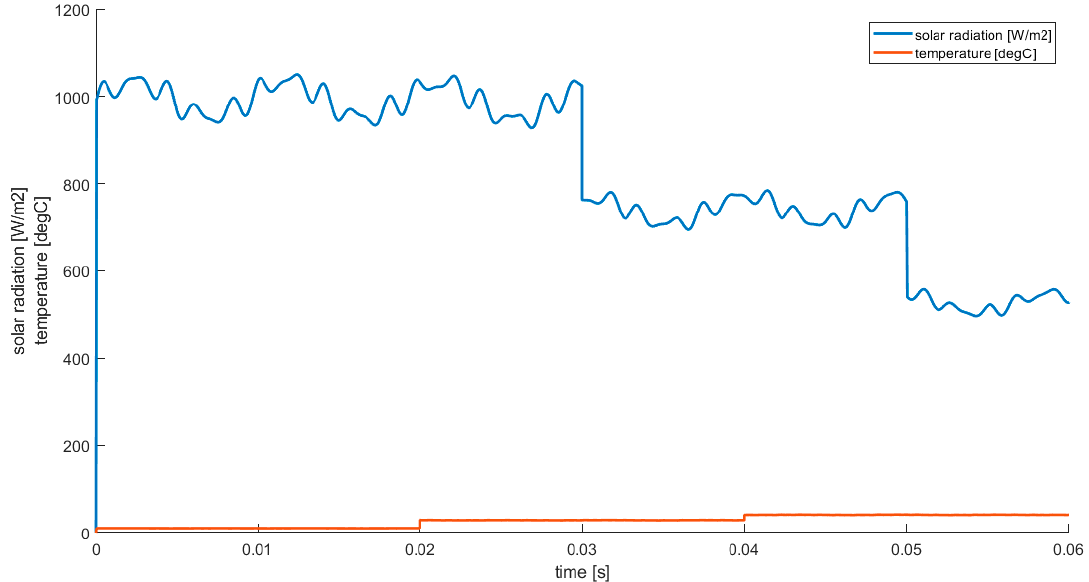
Figure 13. Dynamics of the solar radiation and temperature over time.